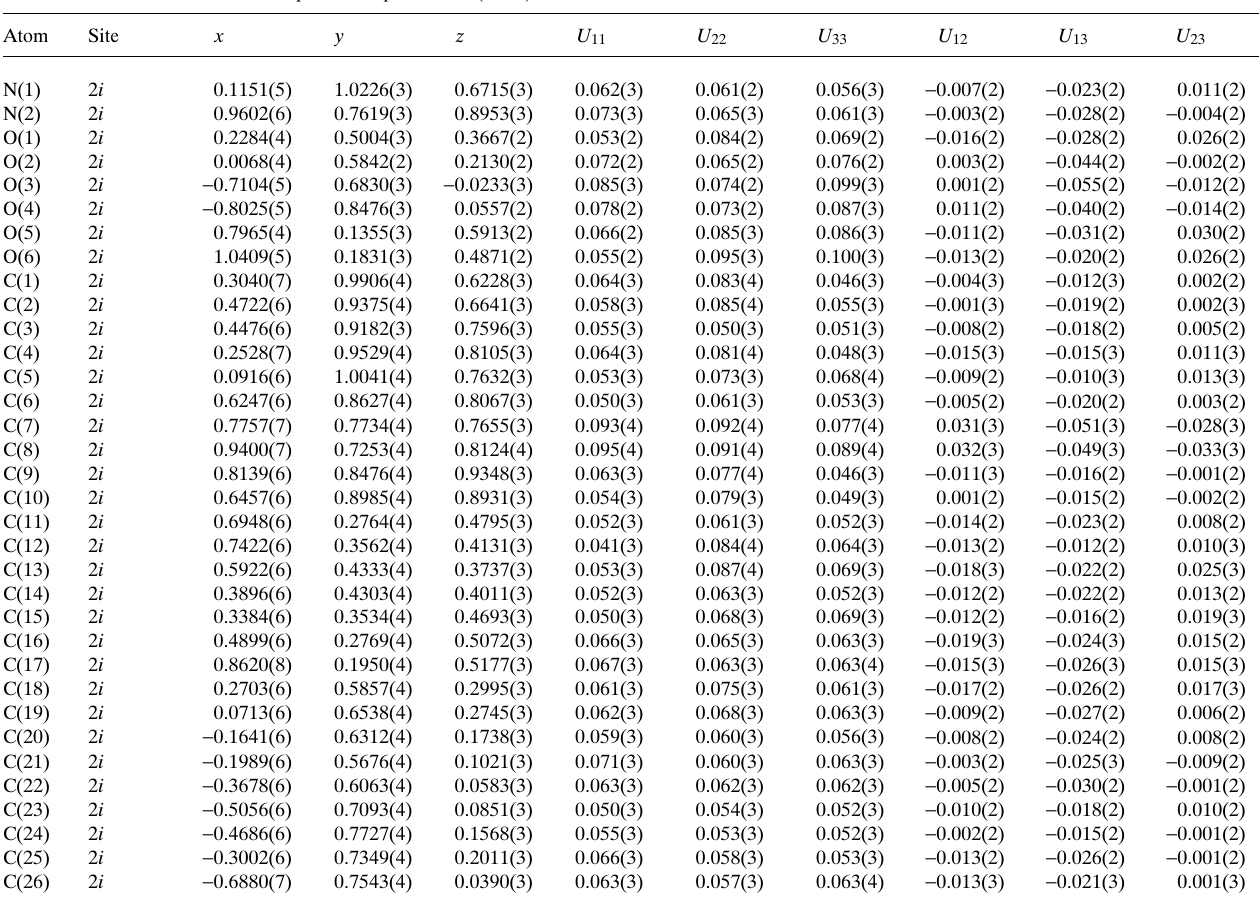
Table 3. Atomic coordinates and displacement parameters (in Å 2 )